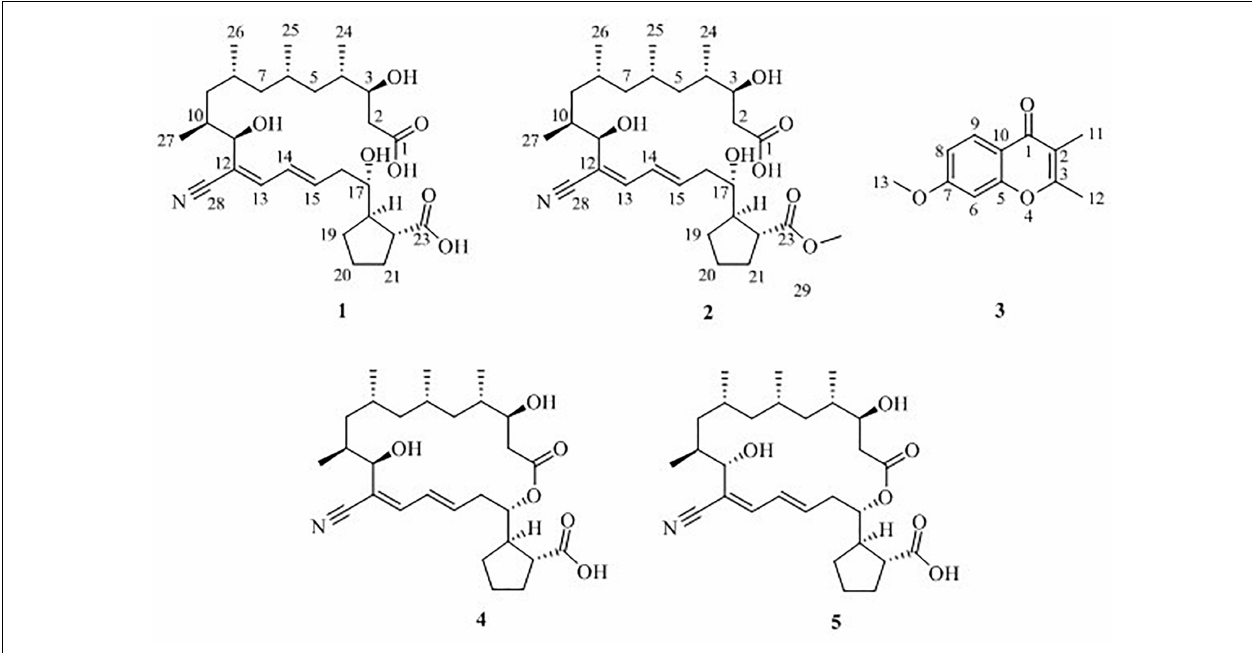
FIGURE 1 | Chemical structures of compounds 1 – 5